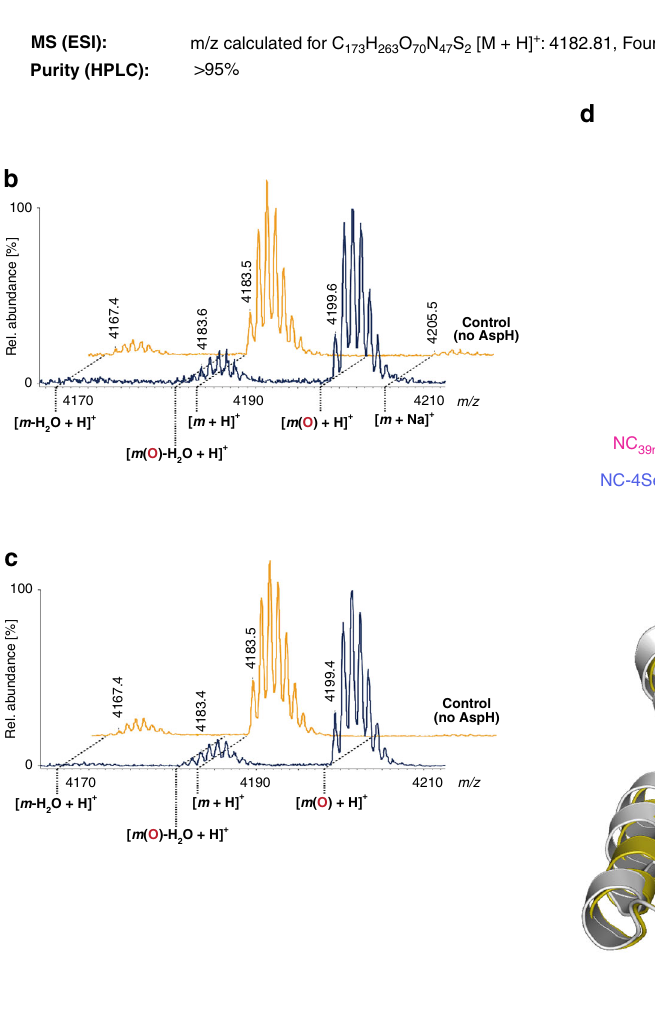
Fig. 8 The AspH-substrate requirement is a ring composed of 10 amino acid residues. End-point turnover reactions were performed as in the Methods Section. Light orange graphs represent controls in which AspH was replaced by buffer. a Schematic structure and calculated mass of the NC-4Ser 39mer peptide featuring a single disul fi de between Cys3 – 4 (green); its sequence is identical to the one of hFX EGF1 39mer (see Fig. 1a), except that Cys90 hFX , 95, 112, 121 are substituted for Ser (light blue) to avoid disul fi de scrambling; the hydroxylation site (Asp103 hFX ) is in red. b >95% Hydroxylation was observed under standard (non-redox) conditions. c >95% Hydroxylation was observed under redox conditions. d Superimposition of the AspH-TPR-Ox:hFX crystal structure (color code: AspH: grey; NC 39mer peptide: magenta) with the AspH-TPR-Ox:NC-Ser 39mer crystal structure (color code: AspH: gold; NC-4Ser 39mer peptide: slate blue) shows a high conservation of the conformations of both enzyme and